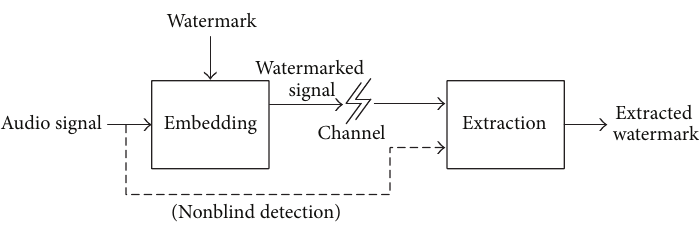
Figure 1: Audio watermarking